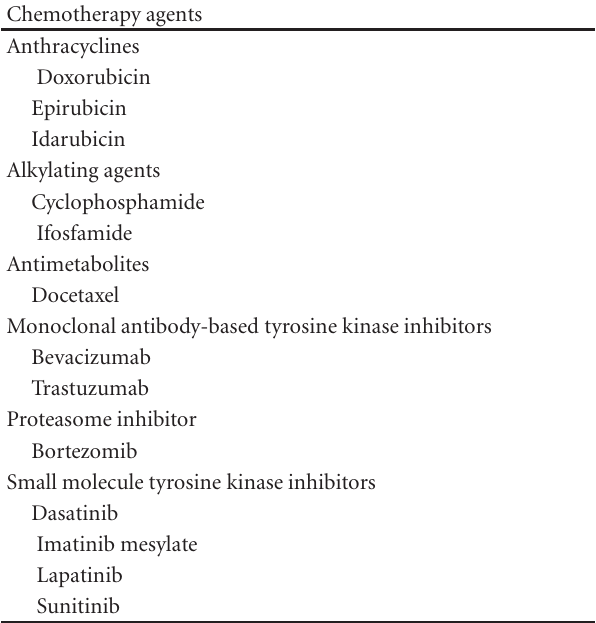
Table 2: Chemotherapeutic agents associated with left ventricular